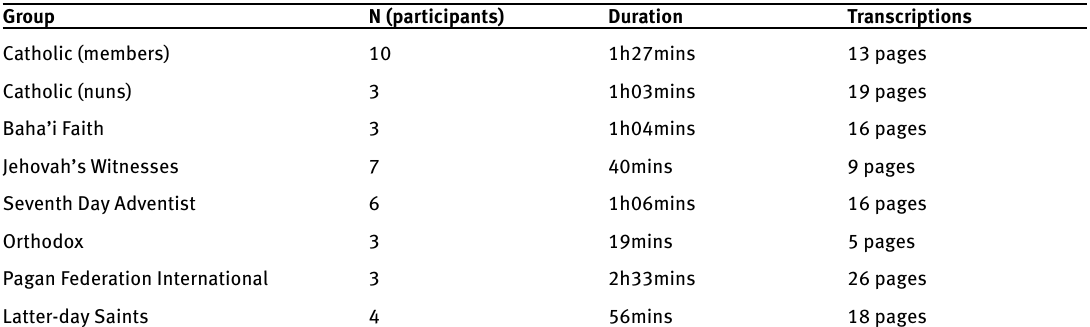
Table 3: Distribution of focus group